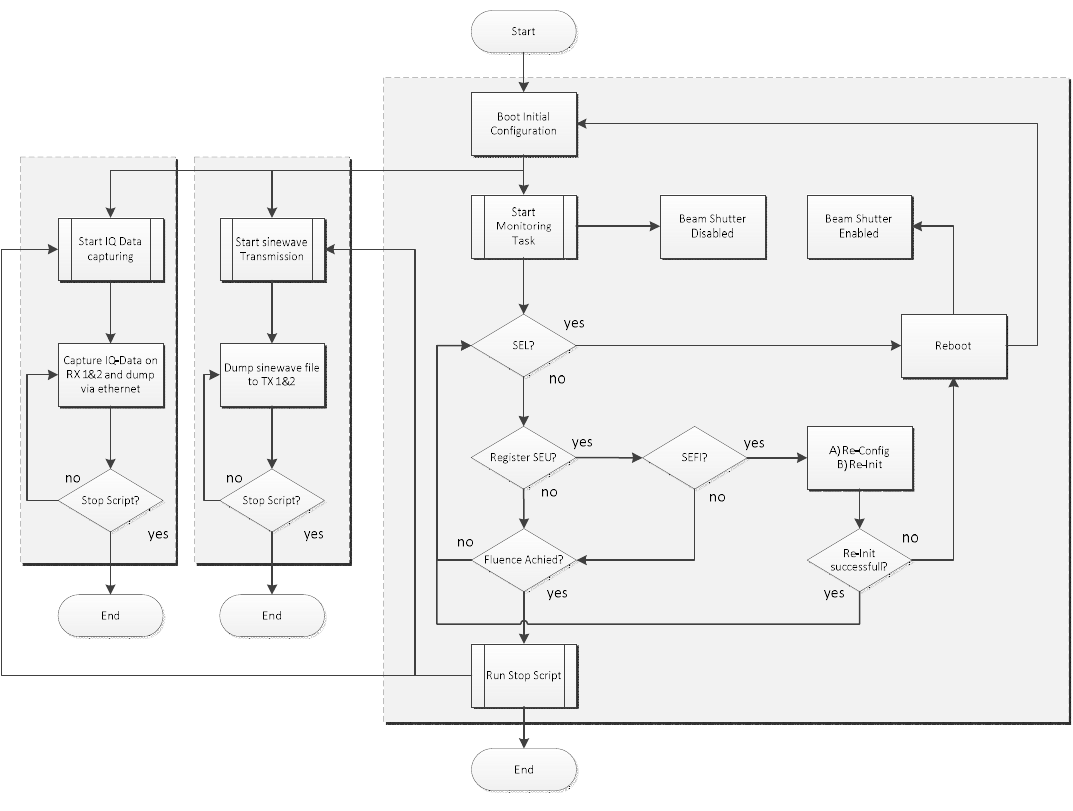
Figure 7. AD9361 heavy ion test flow chart.